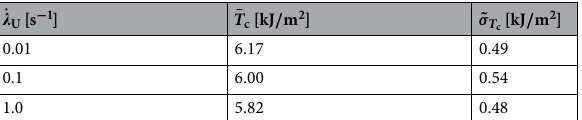
¯ T c and its standard deviation ˙ (cid:31) U from the cyclic pure shear experiment.